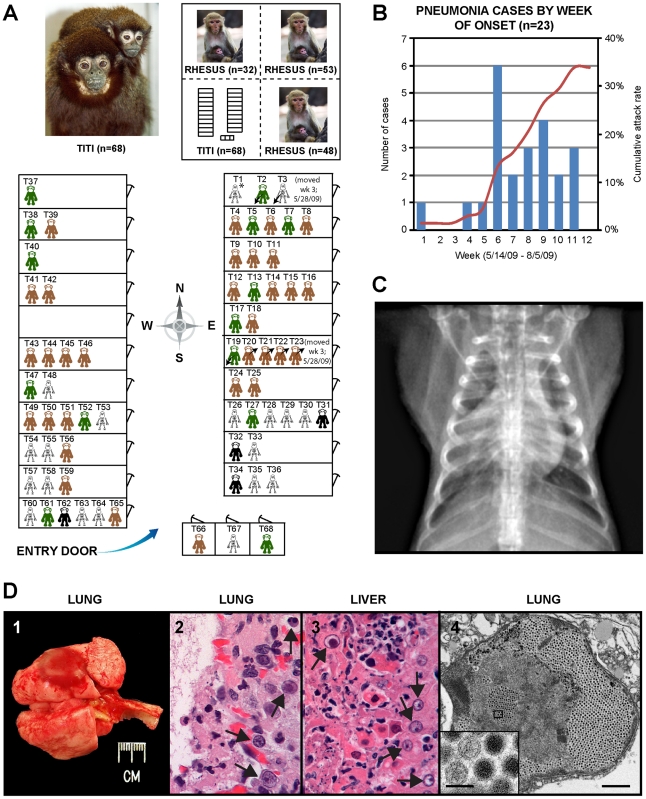
Clinical and epidemiologic features of the titi monkey outbreak.(A) Map of the titi monkey cages situated in one quadrant of a building, showing the locations of asymptomatic, at-risk monkeys (brown or green), affected surviving monkeys (black), and monkeys who died from their illness (skeleton). 3 monkeys were moved into the building (arrows pointing down and to the left) and 4 monkeys out of the building (arrows pointing up and to the right) during the 3rd week of the outbreak. The upper left photograph shows an image of an adult male titi monkey and his infant. The upper right inset shows the location of the titi monkey cages relative to other rhesus monkey cages in the building. Asymptomatic monkeys with positive serum antibody titers to TMAdV 4 months after the outbreak are shown in green. (B) Epidemic curve of the outbreak, with the number of cases in blue and cumulative attack rate in red. (C) Anteroposterior chest radiograph of an affected titi monkey, showing bilateral basilar infiltrates and a prominent right middle lobe consolidation. (D) 1 – gross photograph of lungs at necropsy; the lungs failed to fully collapse upon opening the chest, and a single ∼1.5 cm focus of dark red discoloration (hemorrhage) can be seen in the left caudal lobe. 2 – photomicrograph of H&E stained lung tissue showing a severe diffuse necrotizing bronchopneumonia characterized by the presence of hemorrhage and intranuclear inclusions (arrows). 3 – photomicrograph of H&E stained liver tissue showing a multifocal necrotizing hepatitis with numerous intranuclear inclusions (arrows). 4 – transmission electron micrograph of an affected lung alveolus (scale bar  = 1 µm) filled with adenovirus-like particles (inset, scale bar  = 0.1 µm).